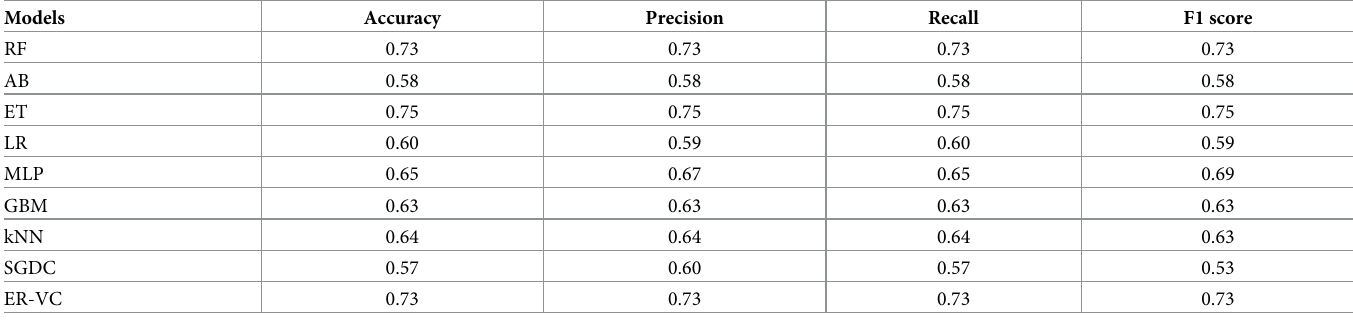
Table 8. Classification results of machine learning models using GloVe with SMOTE.